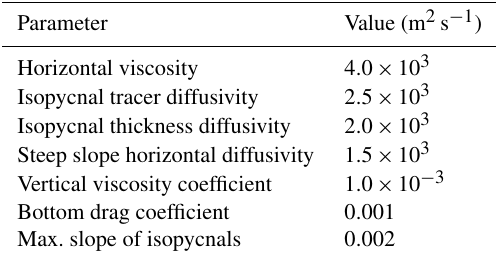
Table 1. Mixing parameters in MOMA.